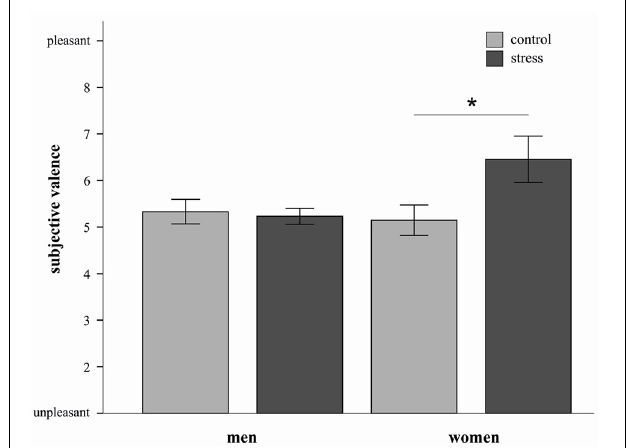
FIGURE 2 | Mean emotional ratings ( ± s.e.m.) to sample pictures in the distract condition are depicted for the stress and control group. Stressed participants in the distract condition reported higher subjective arousal compared to controls. ∗ p < 0 . 05 ( F -test).